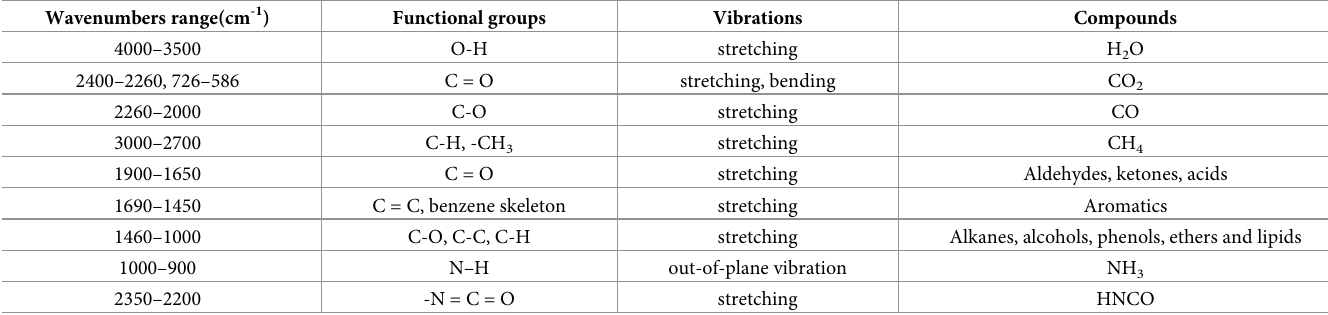
Table 4. The characteristic bands of gaseous products during